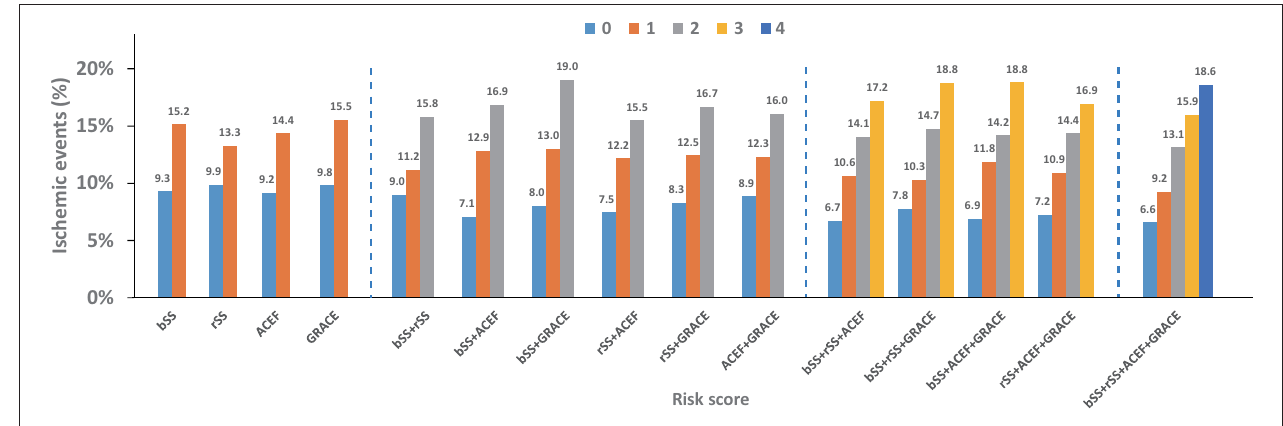
FIGURE 3 | Four-year ischemic events stratified by individual and different combination of risk score (s).